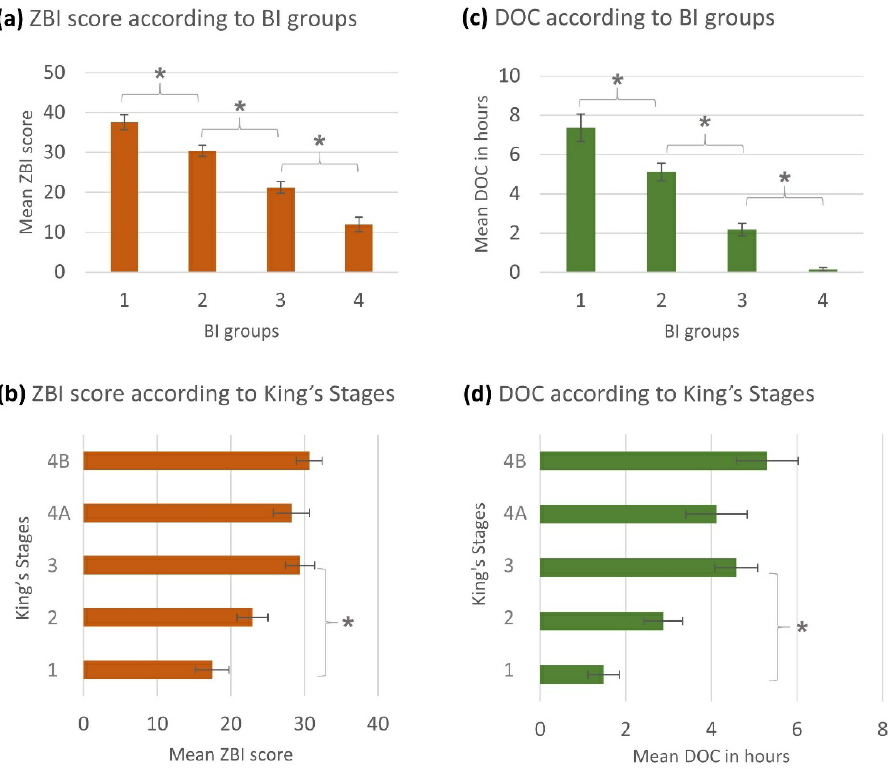
Figure 1. Evaluation of caregivers‘ general burden: Mean scores are presented with standard errors (error bars). Statistically significant findings: ( a ) ZBI-BI groups (ANOVA: p < 0.001; KWT: p < 0.001; r s = − 0.542, p < 0.001, n = 242), ZBI-BI (r p = − 0.555, p < 0.001, n = 242); ( b ) ZBI-King’s Stages (ANOVA: p < 0.001; KWT: p < 0.001; r s = 0.300, p < 0.001, n = 237), ZBI-ALSFRS-R (r p = − 0.460, p < 0.001, n = 237); ( c ) DOC-BI groups ( p < 0.001; KWT: p < 0.001; r s = − 0.636, p < 0.001, n = 249), DOC-BI (r p = − 0.617, p < 0.001, n = 249); ( d ) DOC-King’s Stages ( p < 0.001; KWT: p < 0.001; r s = 0.294, p < 0.001, n = 244) DOC-ALSFRS-R (r p = − 0.452, p < 0.001, n = 244). * = post-hoc: p ≤ 0.05 between subgroups. Abbreviations: ZBI = Zarit Burden Interview; BI = Barthel Index; DOC = duration of caregiving, ALSFRS-R = Revised Amyotrophic Lateral Sclerosis Functional Rating